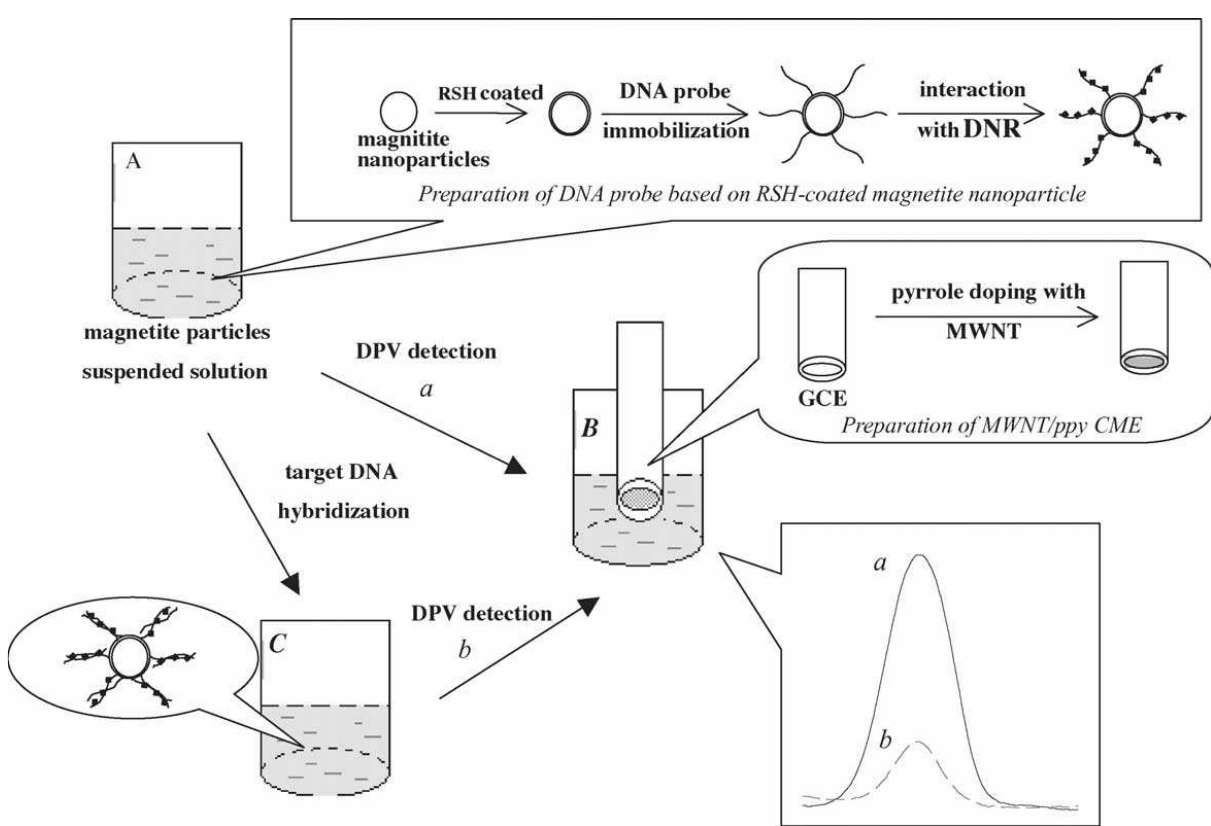
Figure 2. Schematic representation of electrochemical detection of DNA hybridization based on RSH coated magnetite nanoparticles labeled oligonucleotide DNA probe by MWCNTs/ppy GCE. Step A is the preparation of DNA probe, step B is the detection of DNR connected on DNA probe and step C is the hybridization with target sequences and its detection. Reproduced with permission from